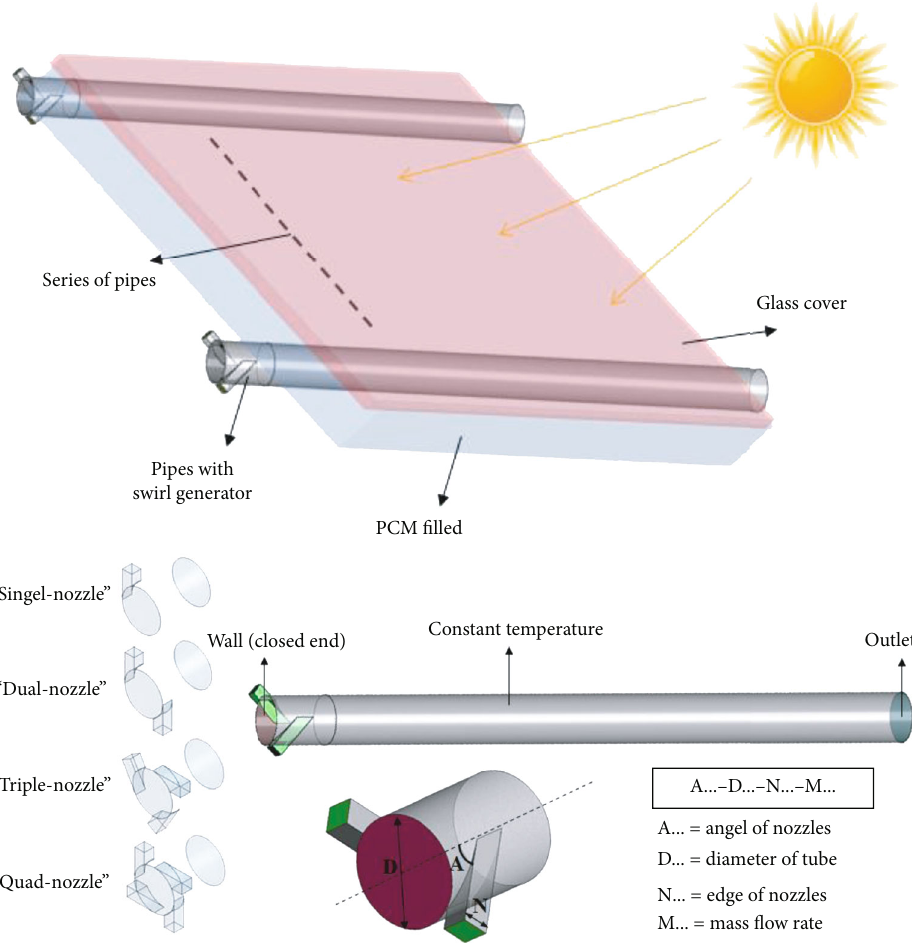
Figure 1: Diagram of fl at plate solar collector with new designed